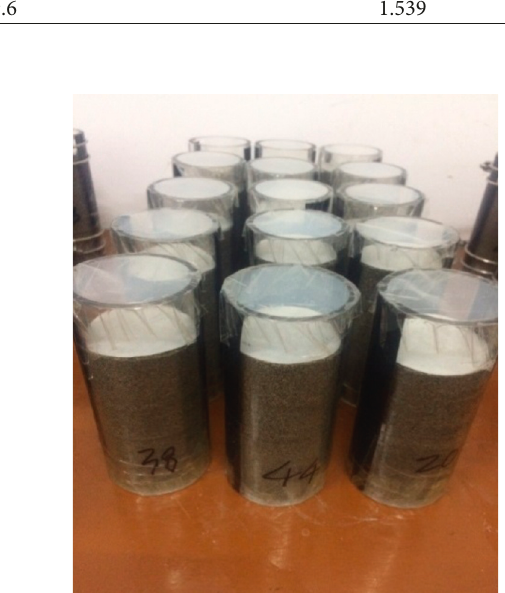
Figure 2: Prepared sample.